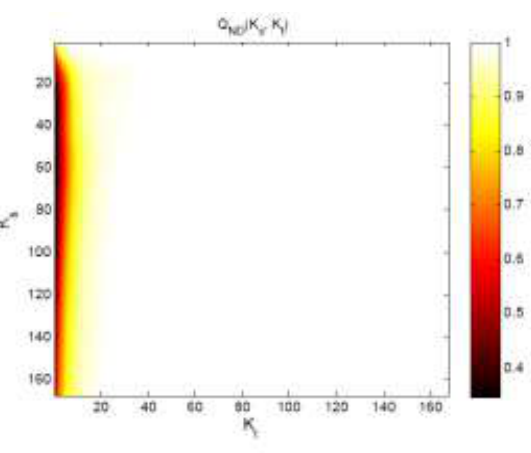
Figure 3. Q ND quality measure for autoencoder